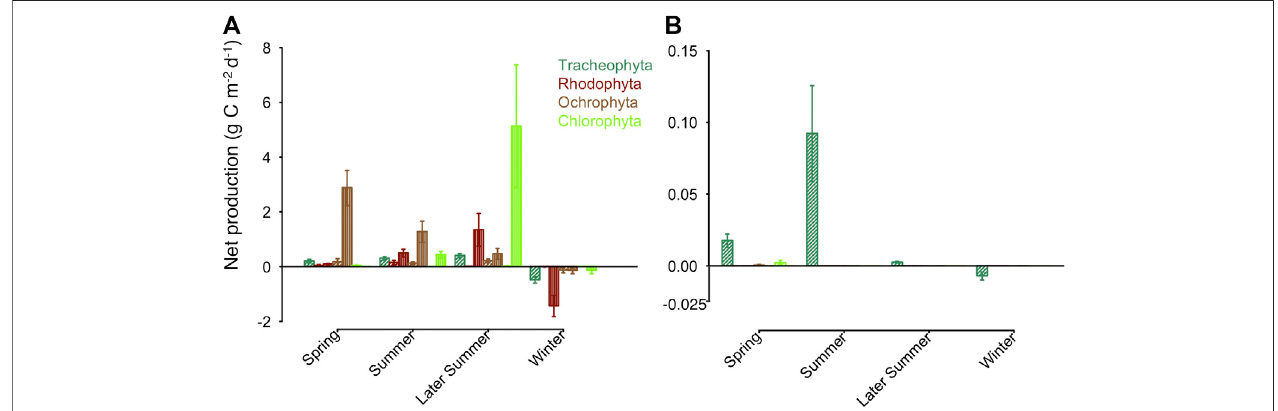
FIGURE 6 | Average daily net primary production for each macrophytobenthic phylum in (A) in g Cm − 2 d − 1 for Vitter Bodden and (B) in g Cm − 2 d − 1 for Grabow. Filamentous growth is shown in vertical lines, all other growth forms in dashed lines. Bars are representing standard error of the